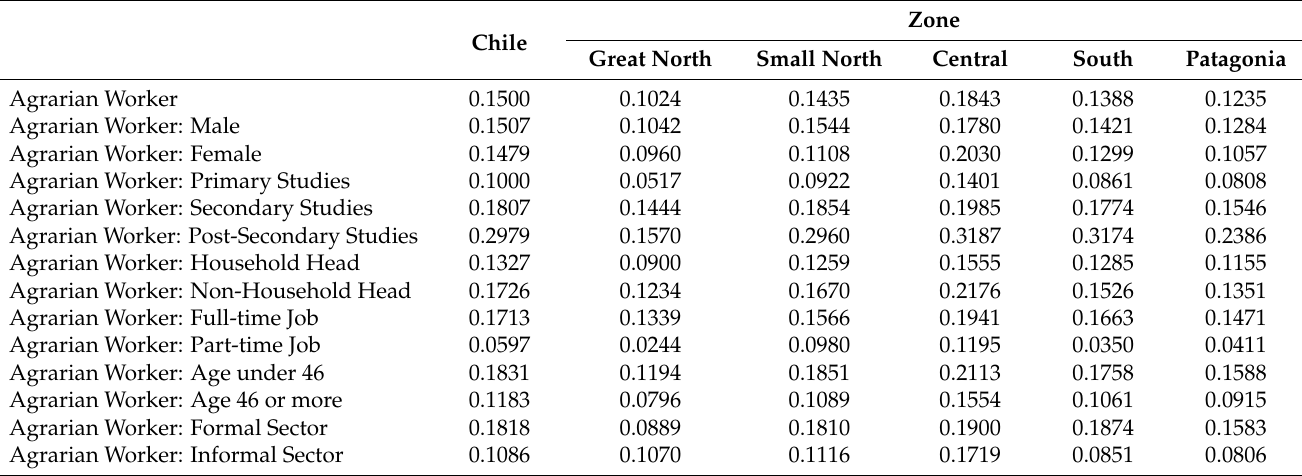
Table 5. Average probabilities of agrarian workers to